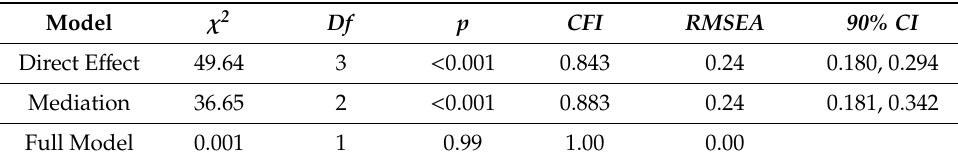
Table 2. Fit indices for three Path Analysis models, N =